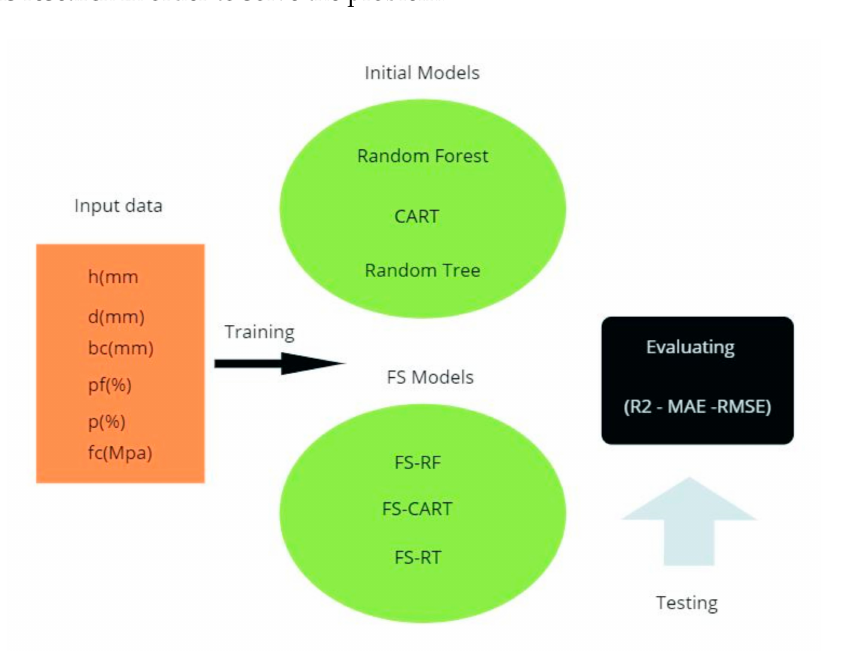
Figure 2. The methodology process of this